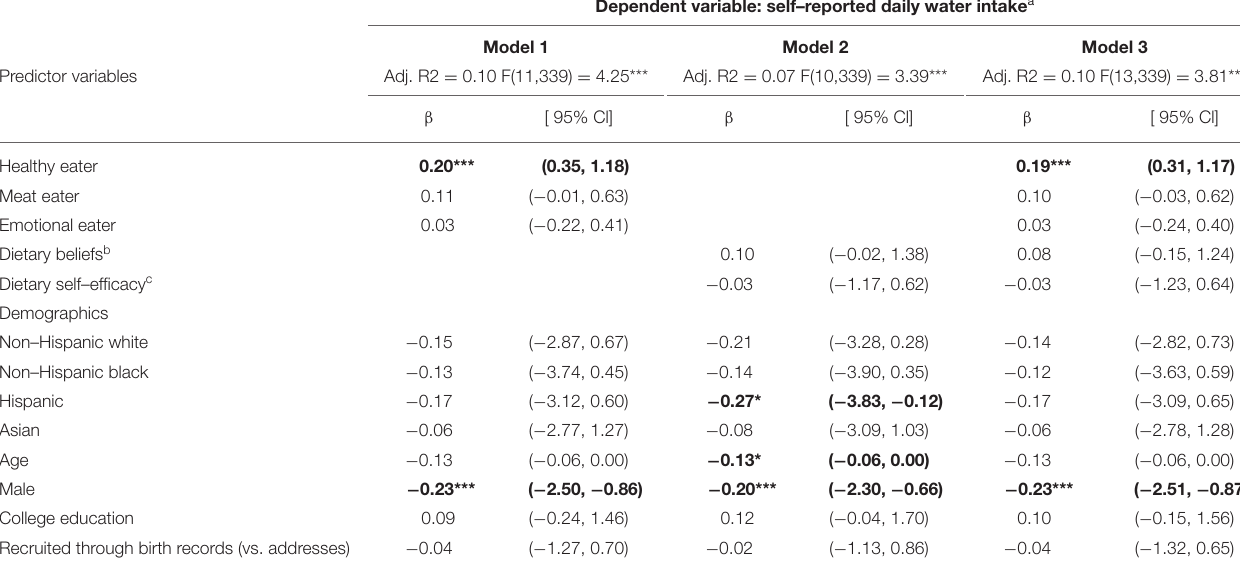
TABLE 3 | Linear regressions predicting self–reported daily water